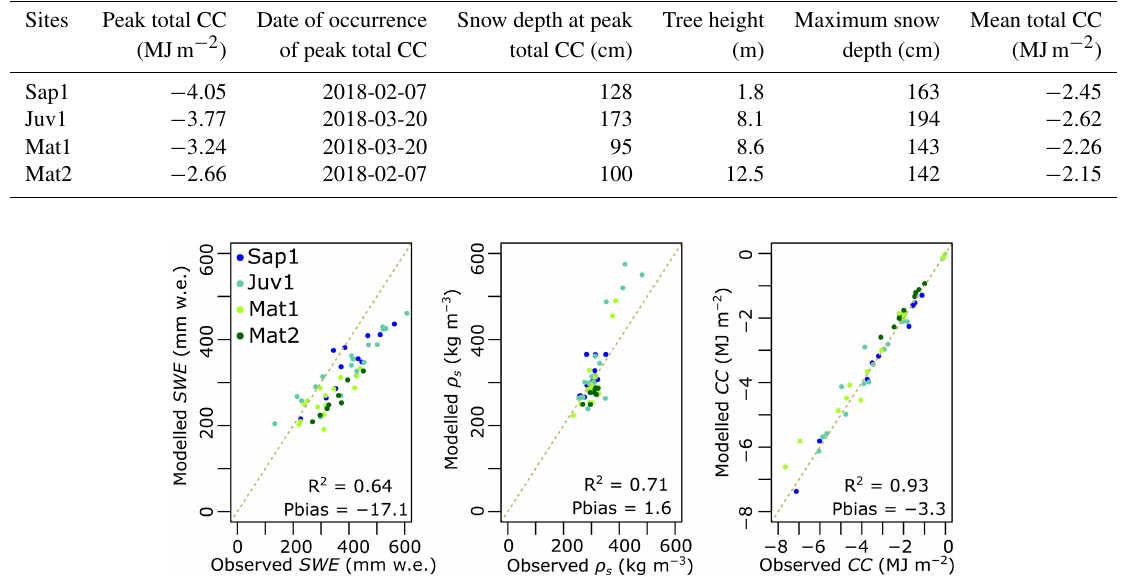
Figure 6. Observed versus CLASS-simulated bulk values of SWE, snow density, and CC. R 2 denotes the coefficient of determination, and Pbias (%) represents the percent